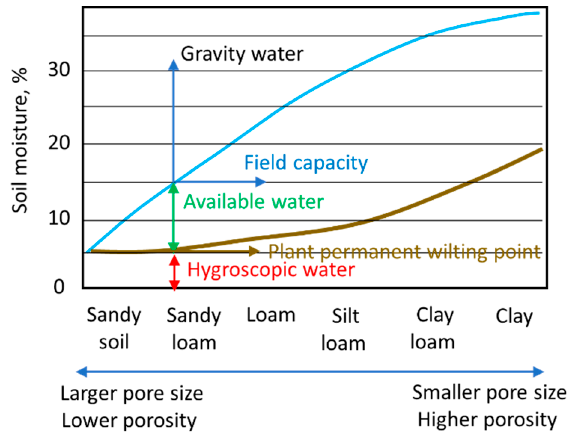
Figure 2. Soil moisture content for various soil textures including hydroscopic, available and gravity water. The blue line indicates the field capacity of a spectrum of soils with a range of pore sizes and other characteristics where excess water (gravity water) has drained. The brown line shows the minimum amount of water in various soils that a plant needs not to wilt (the plant permanent wilting point in the given soil).